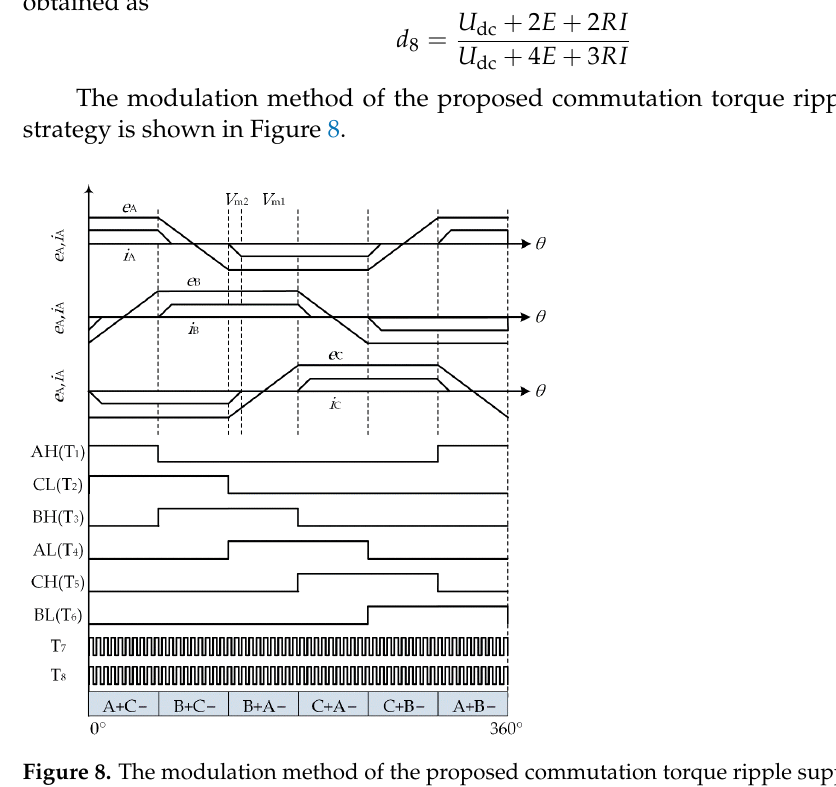
Figure 8. The modulation method of the proposed commutation torque ripple suppression strategy.